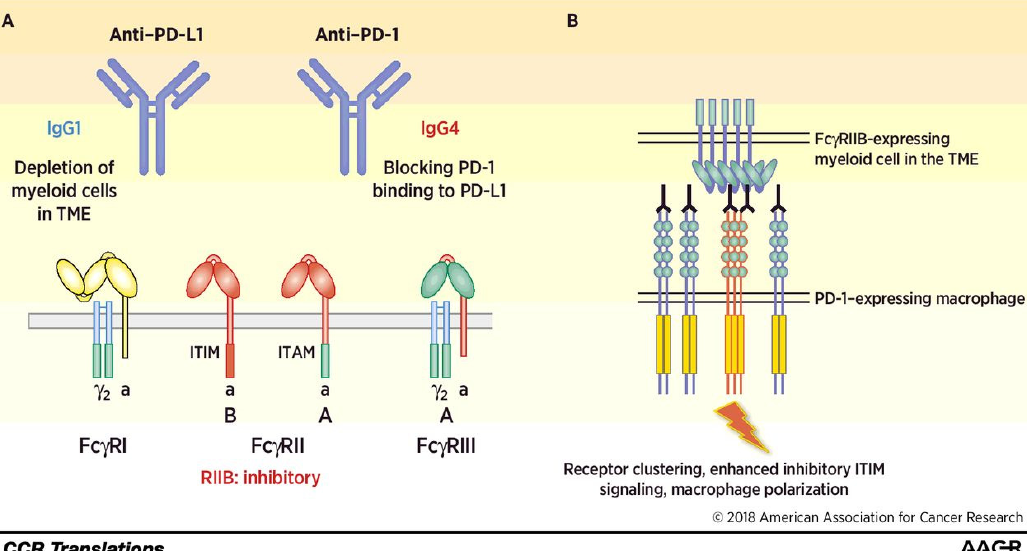
Figure 3. ( A ) Anti-PD-L1 antibodies (IgG1) and anti-PD-1 antibodies (IgG4) have different molecular mechanisms exerted through binding with activating or inhibitory FcRs. ( B ) FcyRIIB-enhanced clustering of PD-1 on macrophages results in polarization via enhanced signaling based on the immunoreceptor tyrosine-based inhibitory motif (ITIM) domain. Reprinted with permission from Ref. [100]. 2019, American Association for Cancer